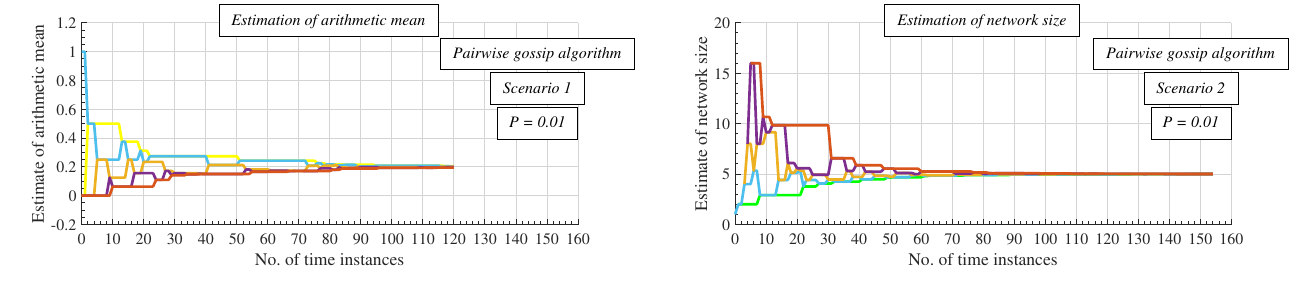
Figure 8. Comparison of evolution of arithmetic mean estimates with evolution of network size estimates—pairwise gossip algorithm is applied.